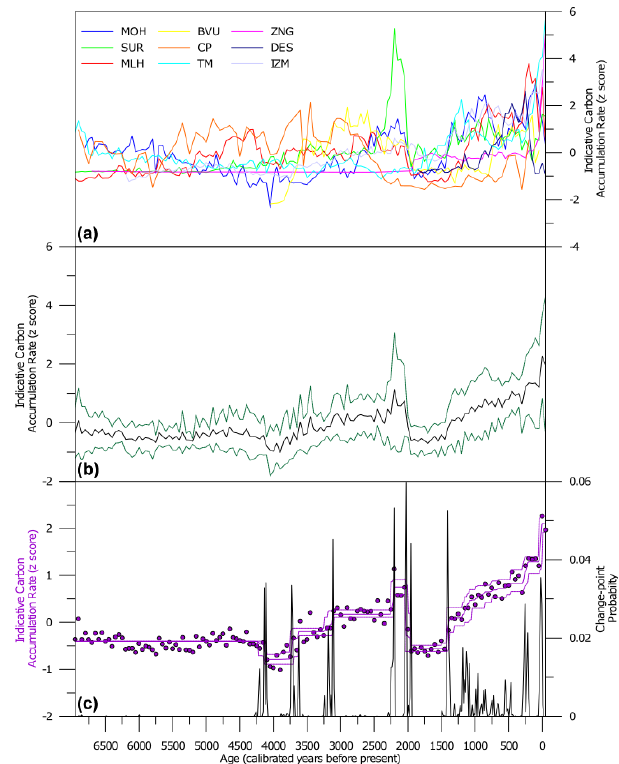
Figure 3. Collated normalized carbon accumulation rates, and the composite of data. Panel (a) displays the 50-year binned, z -score- converted raw data from each site. Panel (b) shows the synthesis of all of the data in panel (a) , with the mean z score indicated us- ing a solid black line. The green lines denote 1 standard deviation. Panel (c) displays the change-point modelling of the composite time series. Filled circles indicate data points. Change-point model out- puts are shown with the solid purple line indicating the mean and the dashed purple lines indicating the 5% and 95% percentiles. The black solid line denotes the likelihood of change-point